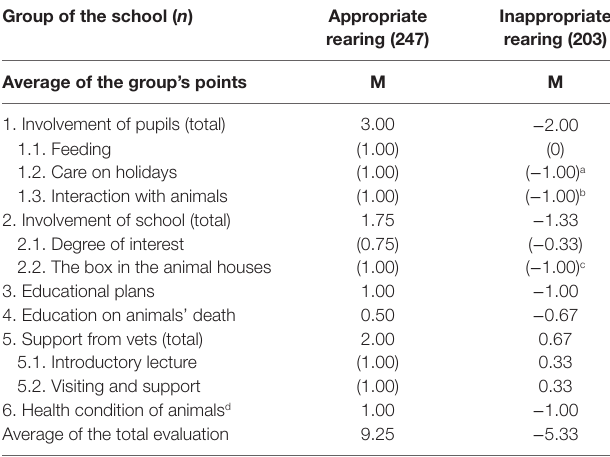
TAbLe 3 | Evaluation of the animal rearing [source: data adapted permission from Ref.